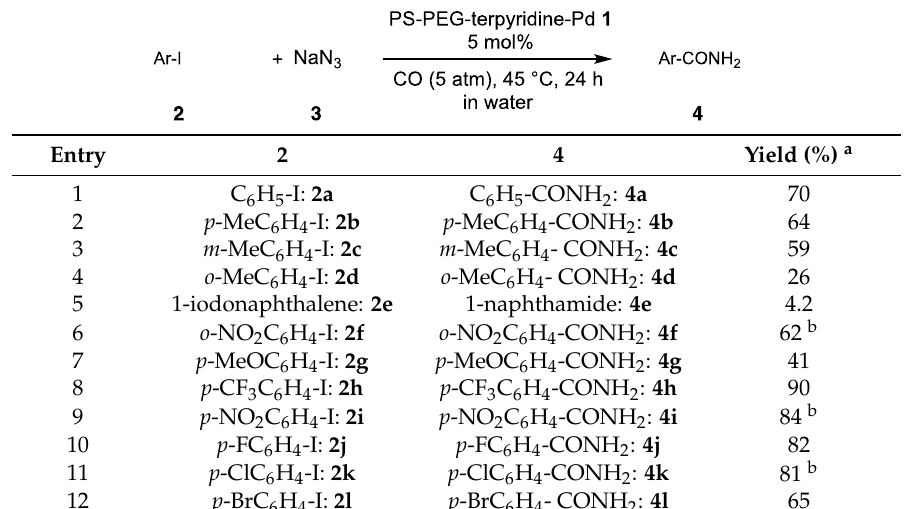
Table 2. Aminocarbonylation of aryl iodides with NaN 3 using polymeric catalyst 1 in water a .